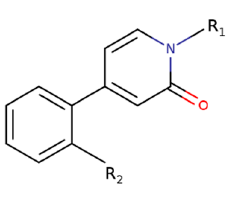
Figure 8. The core structure of 4-phenylpyridin-2-one derivatives.